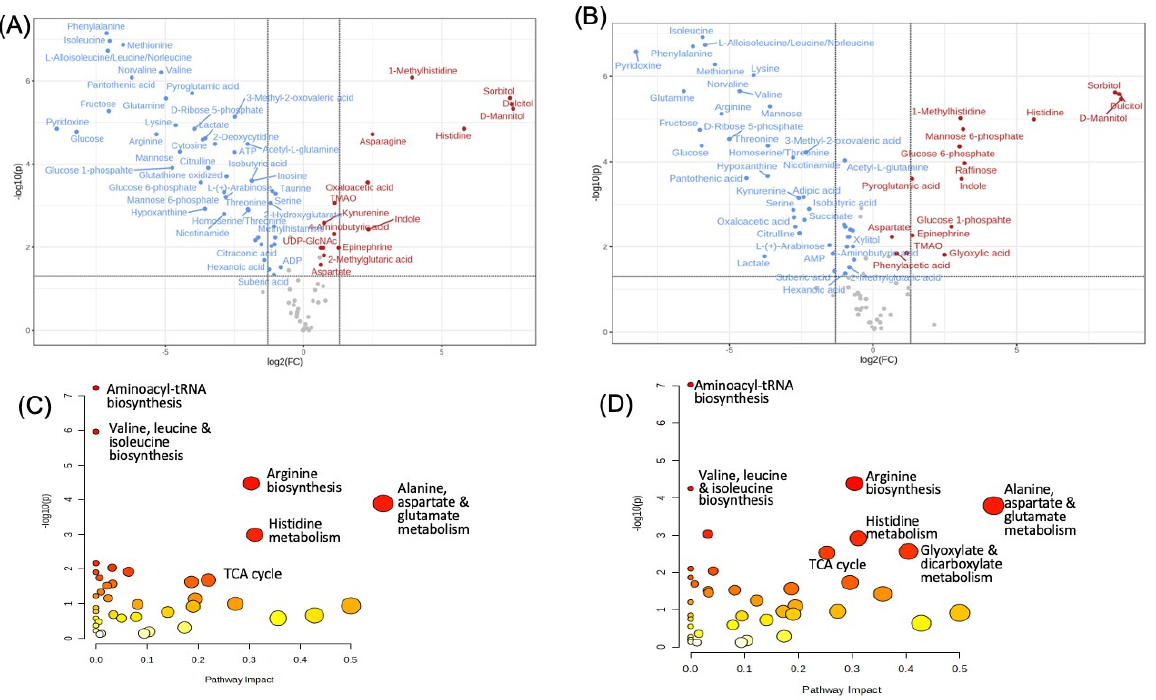
Figure 2. Metabolites and Metabolic Pathways Altered by HTK and CS. AC16 cells seeded in 6-well plates were used for the collection of aqueous metabolites as described in Figure 1 for LC-MS/MS- based metabolomics. A total of 67 or 65 metabolites showed statistically significant differences as determined by Student’s t-test (n = 4, p < 0.05) between control versus HTK or CS and are displayed in the volcano plots ( A , B ) generated by the MetaboAnalyst 5.0 software. The altered metabolic pathways are displayed with the x -axis representing the pathway impact score computed from pathway topological analysis and the y -axis being the -log10 of the p -value obtained from pathway enrichment analysis ( C , D ). The metabolic pathways perturbed by the HTK and CS treatment are displayed in the gradient from yellow to red, reflecting the p -value from statistical analysis, as shown in the y -axis, from non-significant ( ≤ 1 for − log10, p ≥ 0.1, light yellow) to significant ( ≥ 1 but ≤ 2 for − log10, p ≤ 0.01 to p ≥ 0.001, orange) to highly significant ( ≥ 2 for − log10, p ≤ 0.0001, red). The size of the circles reflects the number of metabolites altered in the metabolic pathway ( C , D ).